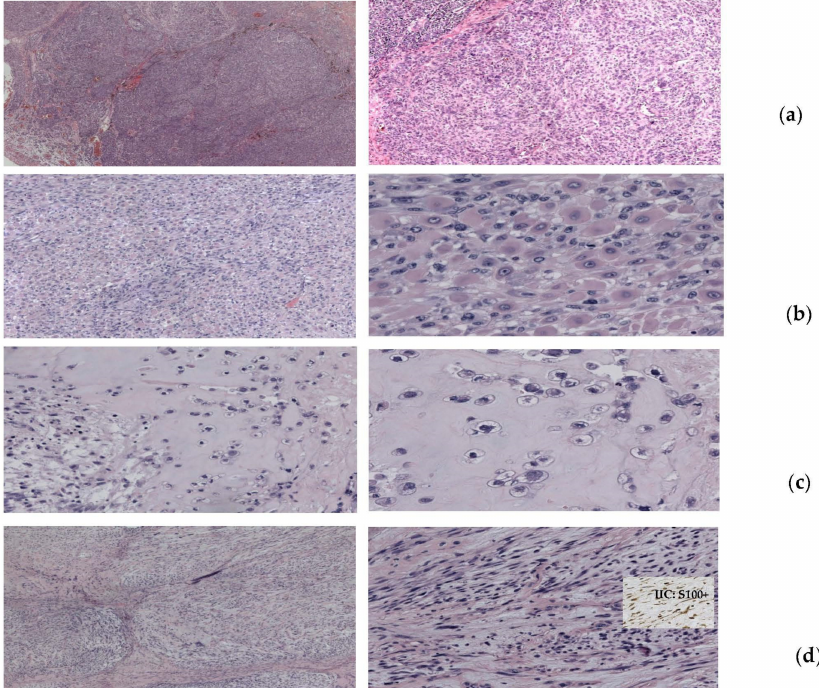
Figure 1. Representative histology of an oligoprogressive lesion of the thoracic wall radically removed with surgery in a patient undergoing anti-BRAF plus anti-MEK targeted therapy. In a pseudolobular pattern with the presence of crammed epithelioid cells of various sizes and hyperchromic nuclei ( a ), numerous aberrant patterns were also present, including rhabdomioid areas with cells of intensely eosinophilic and dense cytoplasm and hypercromic eccentric nuclei ( b ), chondroid areas with cell nests immersed in a cartilaginous-like stroma ( c ), and myxoid areas with spindle cells immersed in abundant clear stroma ( d ). IIC staining showed positivity for S100 protein in all areas.